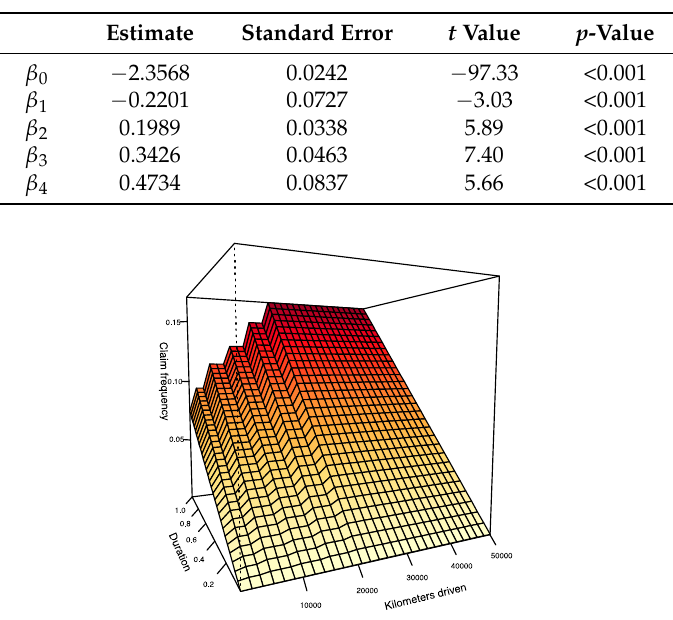
Table 7. Results of the estimation of model 3.